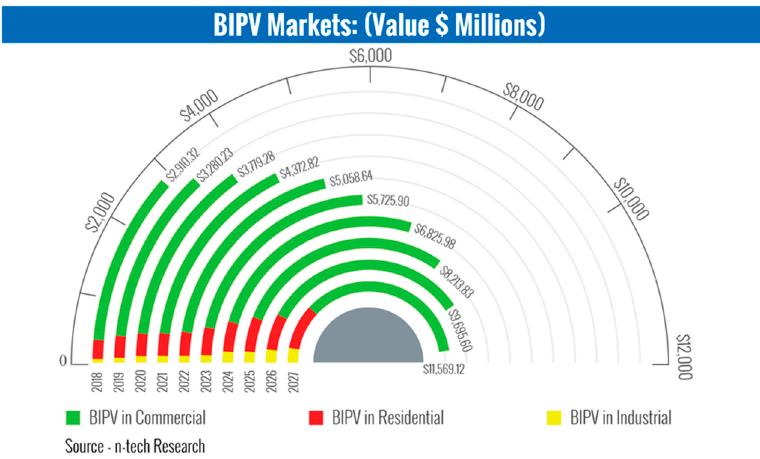
Figure 2. The market value of BIPV [16].